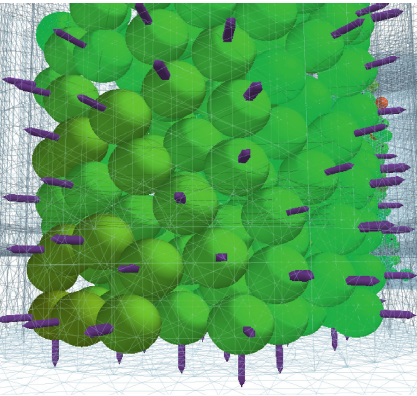
Figure 7: Force diagram of the shell